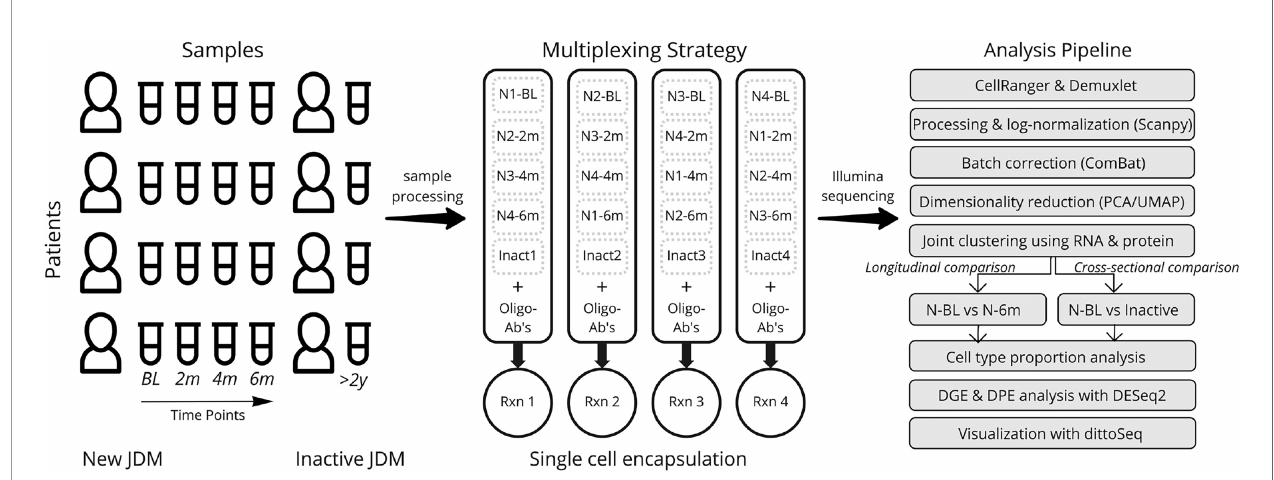
FIGURE 1 | An overview of the experimental design, multiplexing strategy, and analysis pipeline. Timepoints refer to longitudinal samples obtained from the same patients at BL=baseline, 2m=2 months, 4m=4 months, 6m=6 months; N refers to “ New-JDM ” . Rxn, reaction; DGE, differential gene expression; DPE, differential protein